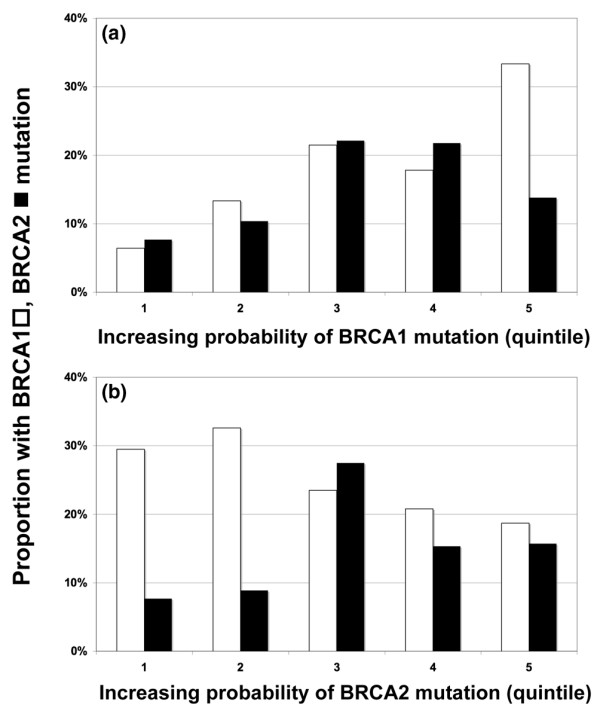
Relationship between estimated probability and predicted relative frequency or BRCA1 and BRCA2 mutations. Women unaffected at time of interview were ranked in quintiles according to their probability of carrying either a (a) BRCA1 or (b) BRCA2 mutation, as estimated by a batch program implementing the Tyrer-Cuzick algorithm, without input of family or individual mutation status. The proportion of women that tested positive for either a BRCA1 (open bars) or BRCA2 (closed bars) mutation is plotted on the vertical axis.